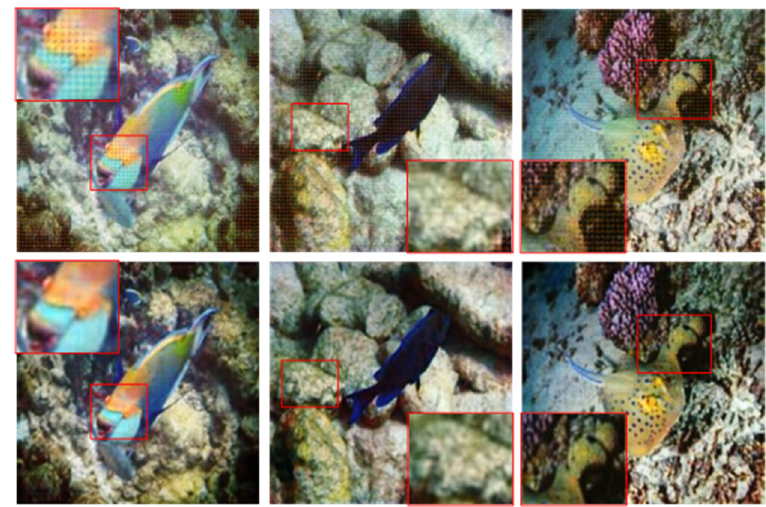
Figure 6. Visual comparison with UGAN on EUVP dataset. The first row is UGAN, and the second row is the proposed method.